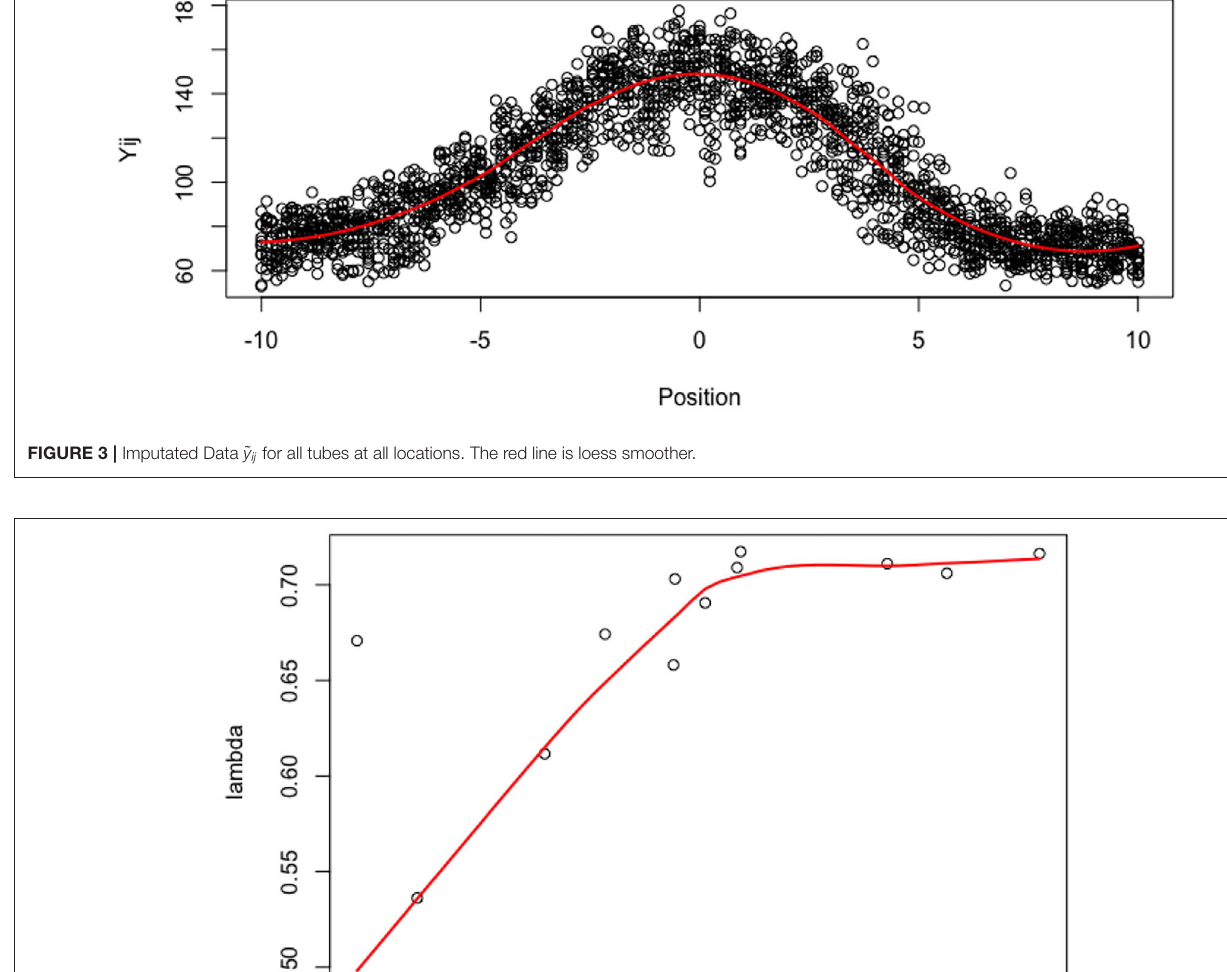
faster the positive feedback function grows than the negative feedback function when the active ROP1 concentration goes to